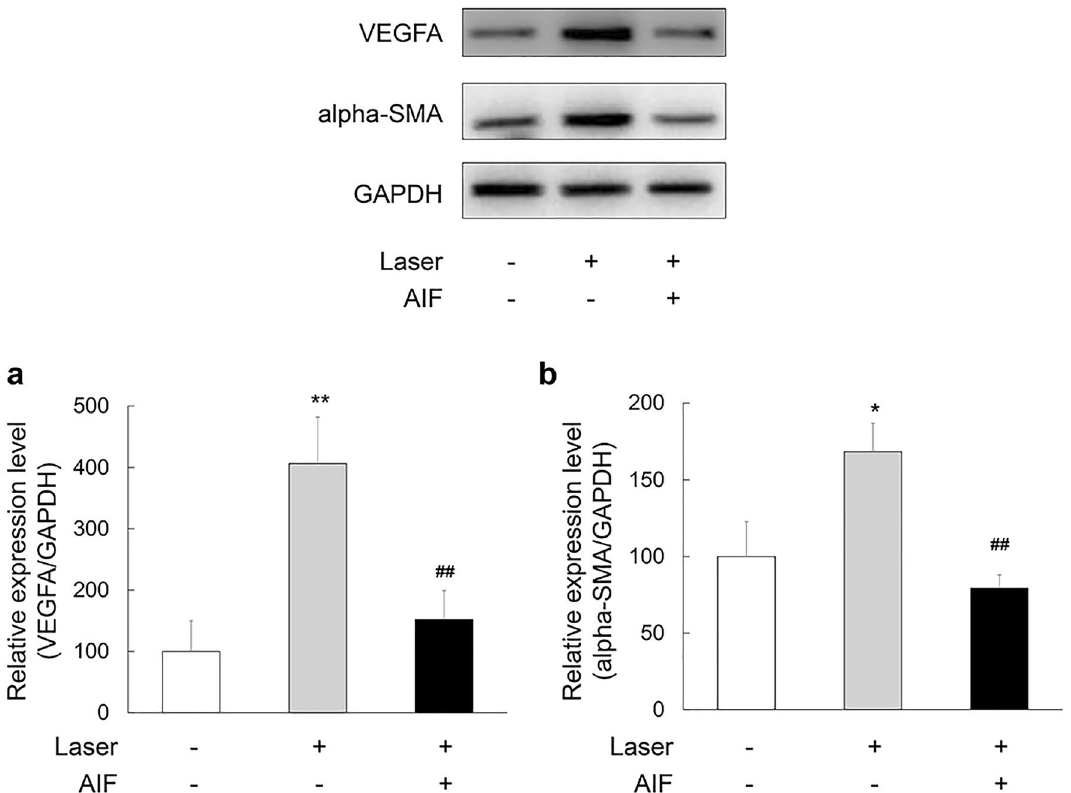
Figure 5. Inhibitory effects of alpinumisoflavone (AIF) on VEGFA and alpha smooth muscle actin (alpha- SMA) expression in the laser-induced choroidal neovascularisation (CNV) mouse model. Intravitreal injection of 25 mg/mL AIF was administered immediately after laser exposure. Equal amounts of protein from laser- exposed mice eye tissue lysates were analysed for expression of the indicated proteins. Protein expression in CNV of laser-exposed eyes of mice was measured a week after laser exposure by western blot analysis. Data were analysed using one-way ANOVA followed by the Holm-Šídák post-hoc t-test (* p < 0.05 and ** p < 0.01 vs. non-laser exposed group, ## p < 0.01 vs. only Laser exposed group) and the results are expressed as mean ± S.E. (n = 4–5). Uncropped blot images are presented in supplementary information (Supplementary Fig.